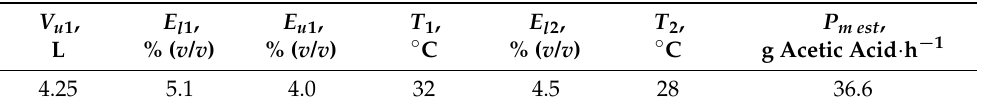
Table 8. Values of the operational variables needed to maximize P m est